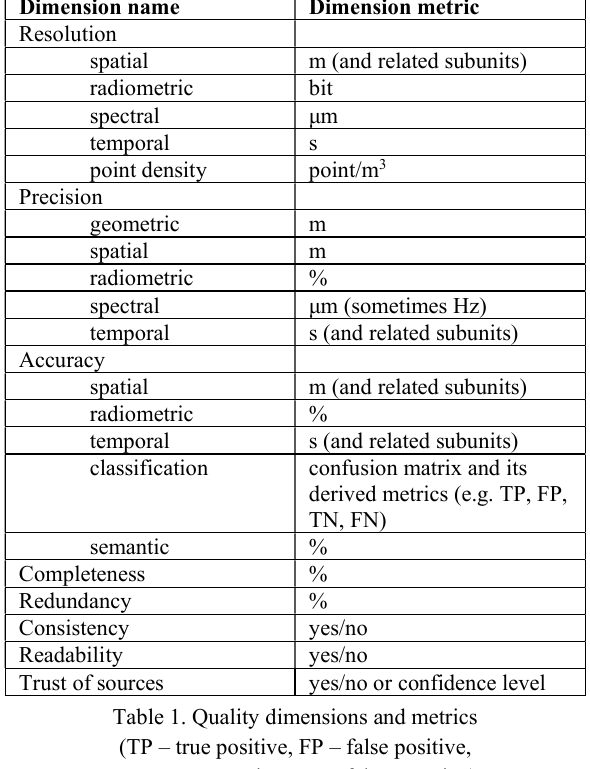
Table 1. Quality dimensions and